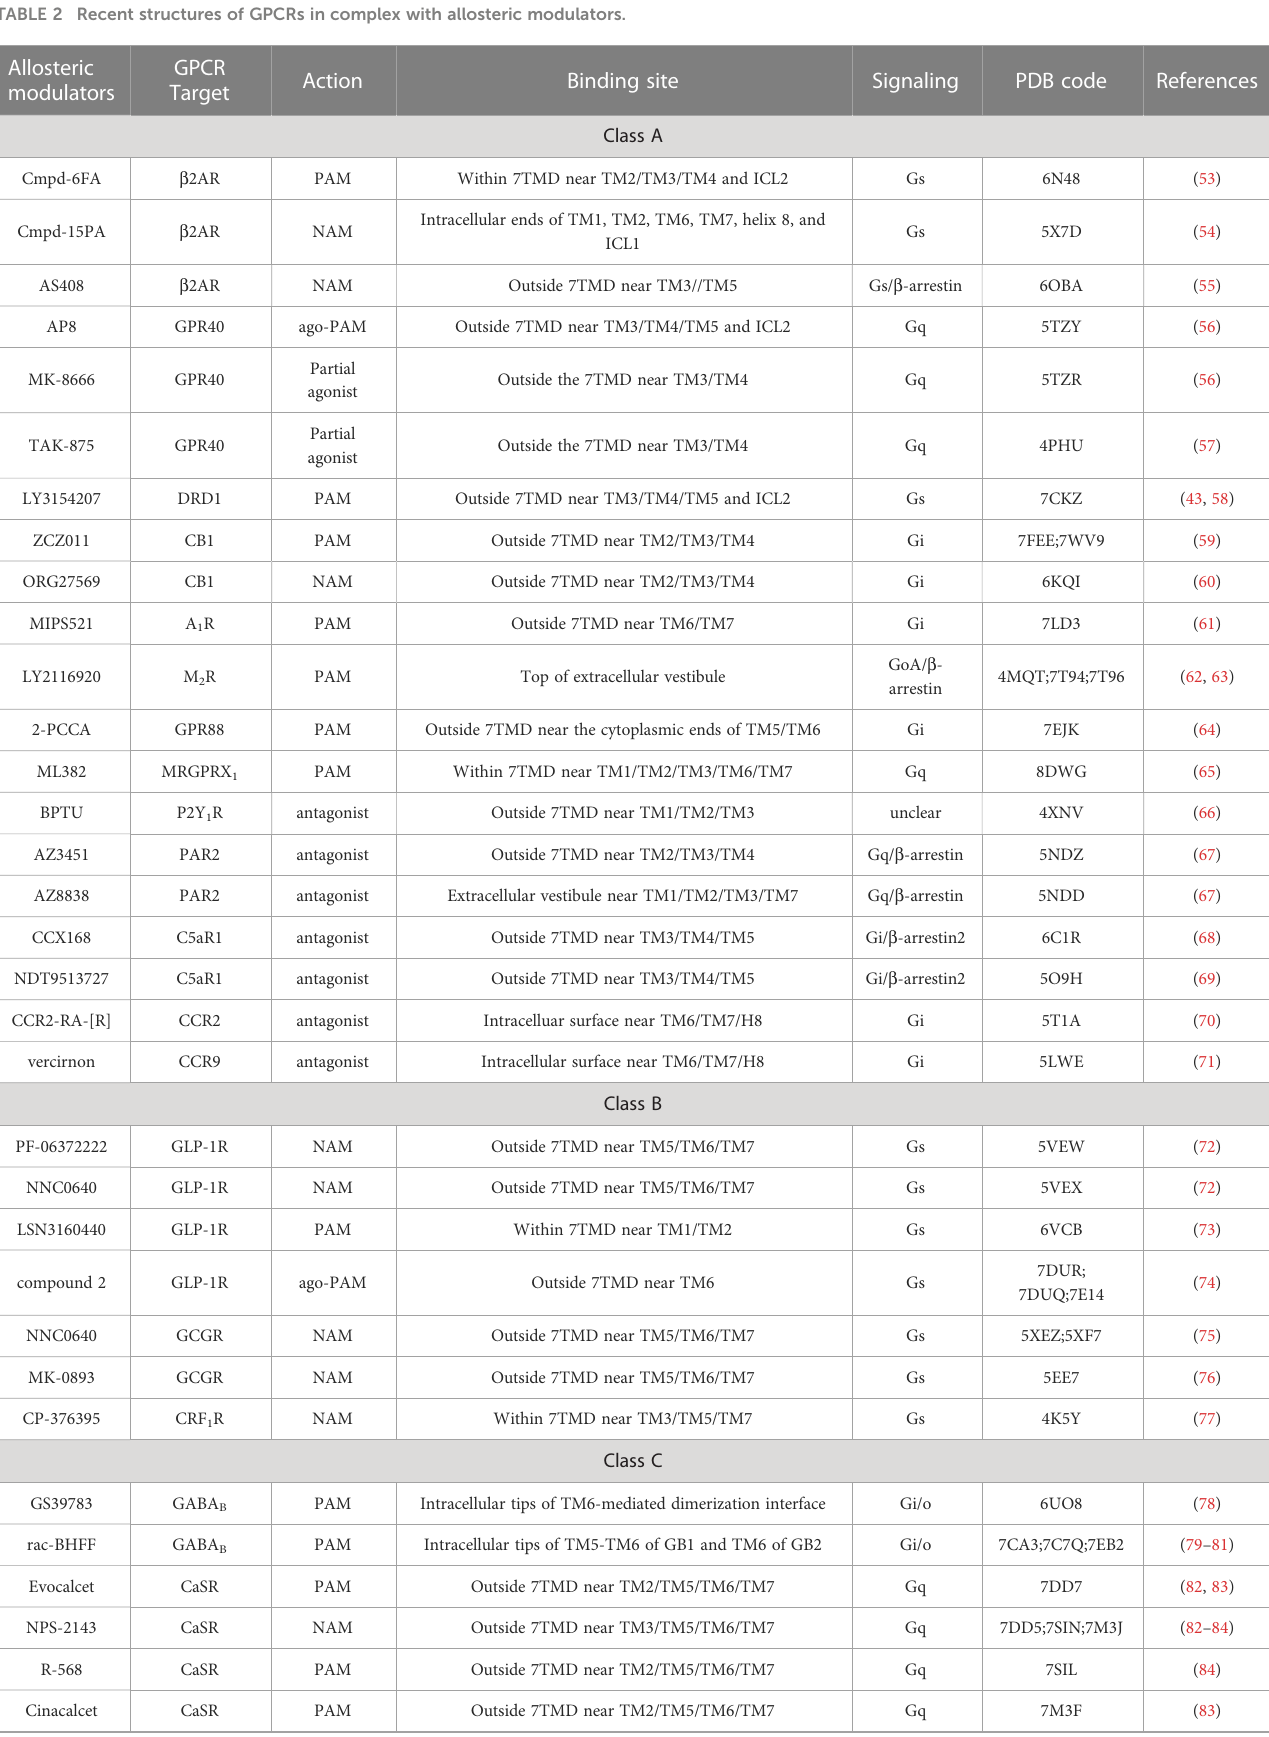
TABLE 2 Recent structures of GPCRs in complex with allosteric